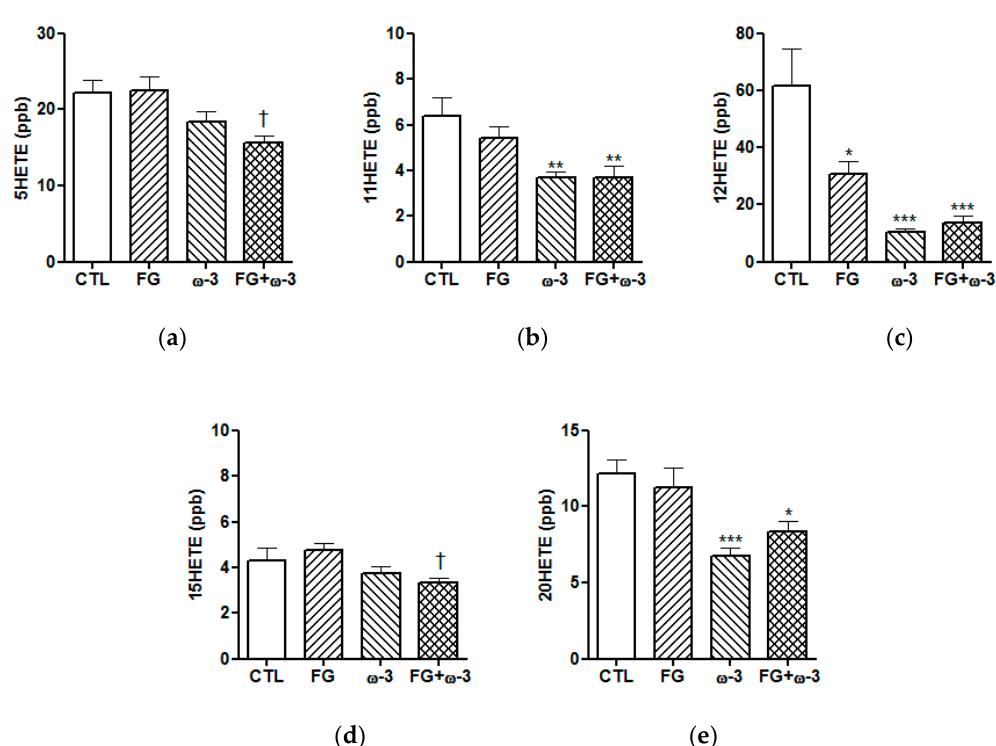
Figure 2. Lipid mediators from arachidonic acid (ARA): 5HETE ( a ), 11HETE ( b ), 12HETE ( c ), 15HETE ( d ) and 20HETE ( e ) in plasma, at the end of the study of the different groups (CTL, FG, ω -3 and FG + ω -3) of Sprague-Dawley rats fed a standard diet for 23 weeks. Data are presented as means with their standard error. Comparisons were conducted using one-way ANOVA and Tukey’s multiple comparisons test. * p < 0.05, ** p < 0.01, *** p < 0.001 vs. CTL; † p < 0.05 vs. FG.